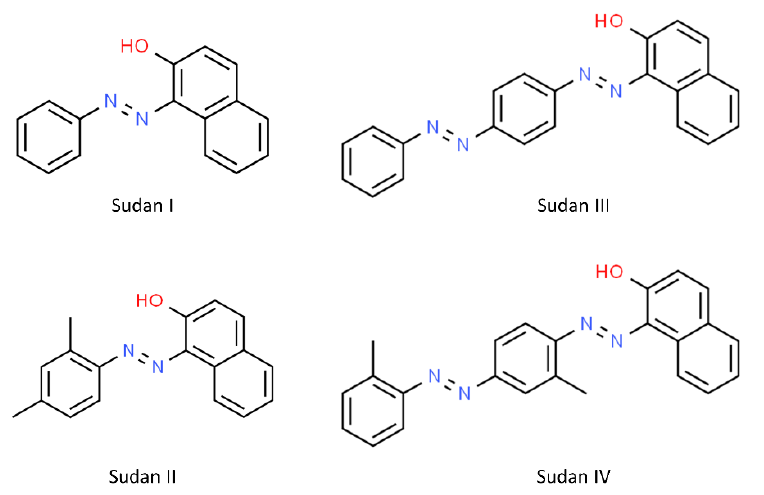
Figure 2. Molecular structures of Sudan dyes I–IV. These structures were taken from ChemSpider (https://www.chemspider.com).